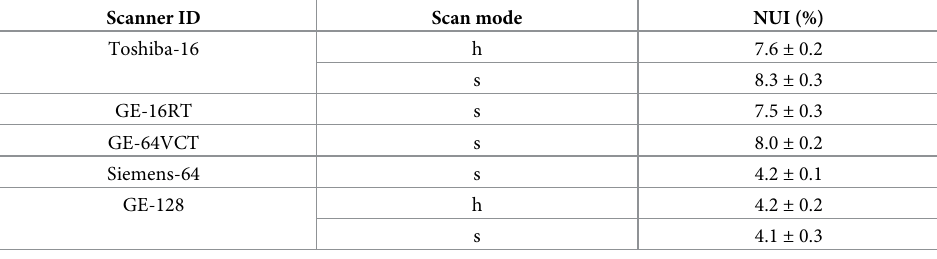
Table 8. NUI values (mean value ± standard deviation across five repeated measurements) for each CT scanner/ acquisition